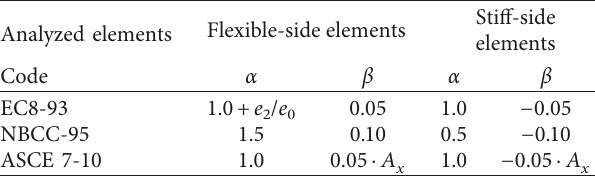
Table 1: Design eccentricity